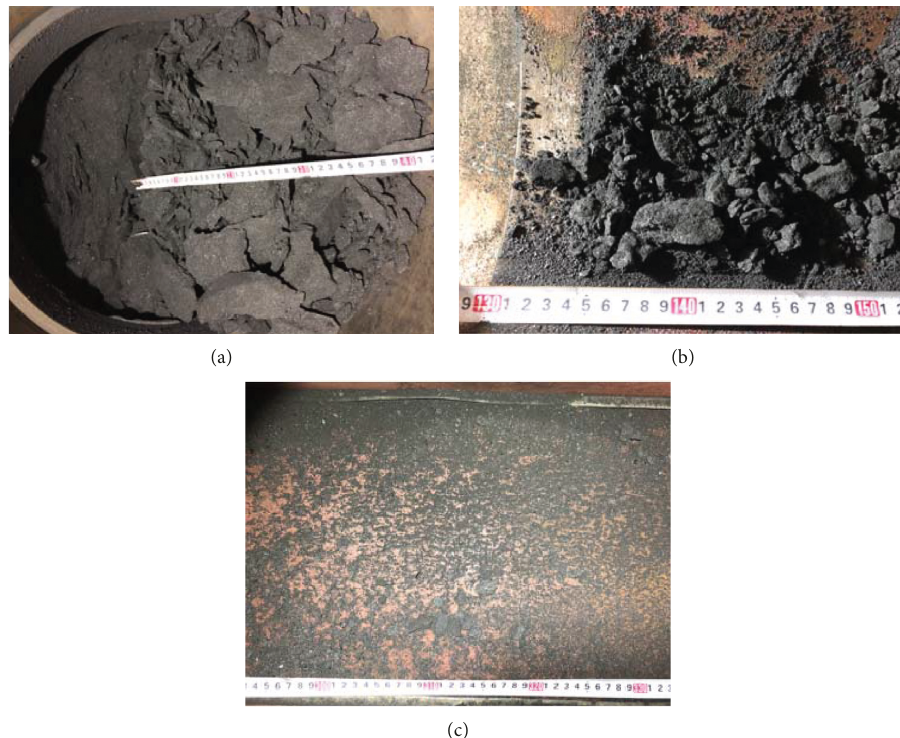
Figure 8: The distribution of outburst pulverized coal in the pipeline. (a) 0 ∼ 0.40m, (b) 1.30 ∼ 1.50m, and (c) 2.84 ∼ 3.30 m.